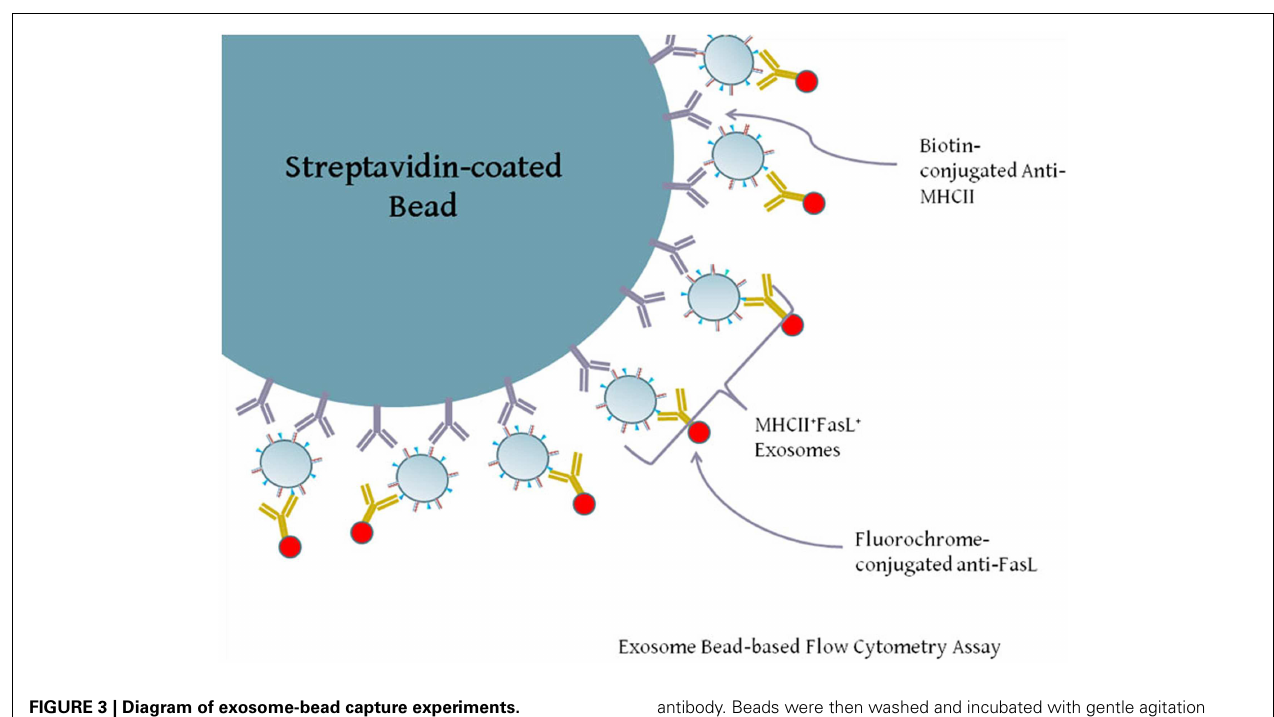
FIGURE 3 | Diagram of exosome-bead capture experiments. Exosomes are too small to be accurately detected by standard flow cytometry, and so must be linked in aggregate to larger beads for flow cytometric analysis. Polystyrene beads coated with streptavidin were incubated with biotin-conjugated anti-HLA-DR or an isotype control